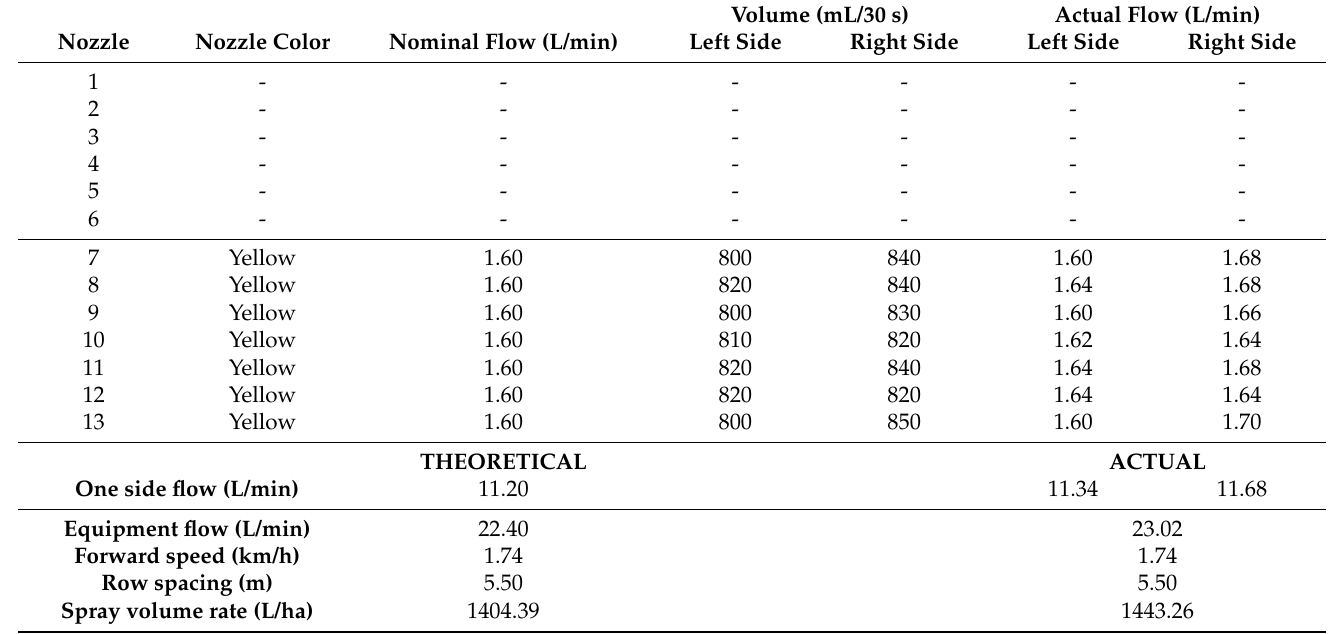
Table A22. Selection and calibration of nozzles for the C1 sprayer, with the following configuration: No adjusted to the vegetation/High & Low fan speed/Low spray volume rate/Drift-reducing nozzles (Coarse)/Pressure: 12